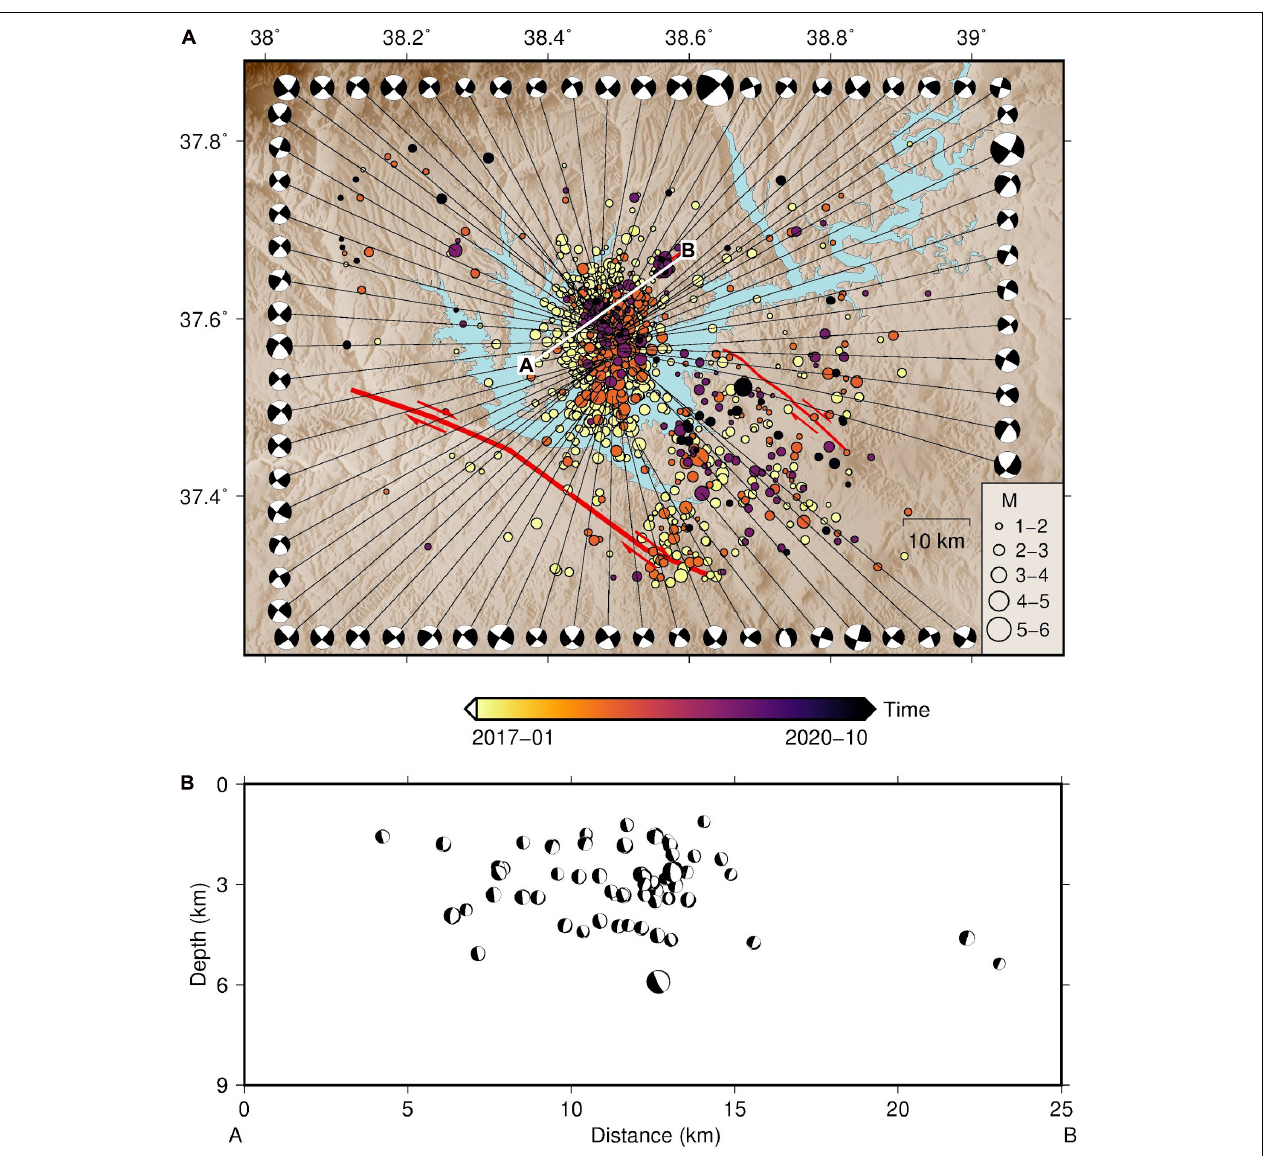
FIGURE 6 | (A) Focal mechanism solutions for 68 events that occurred between 2017 and 2020. The recorded epicenters are color-coded in time. The red lines show the faults with their slip direction. (B) The cross-section of the (A-B) profile in the study area showing the centroid depths mostly less than 6 km.